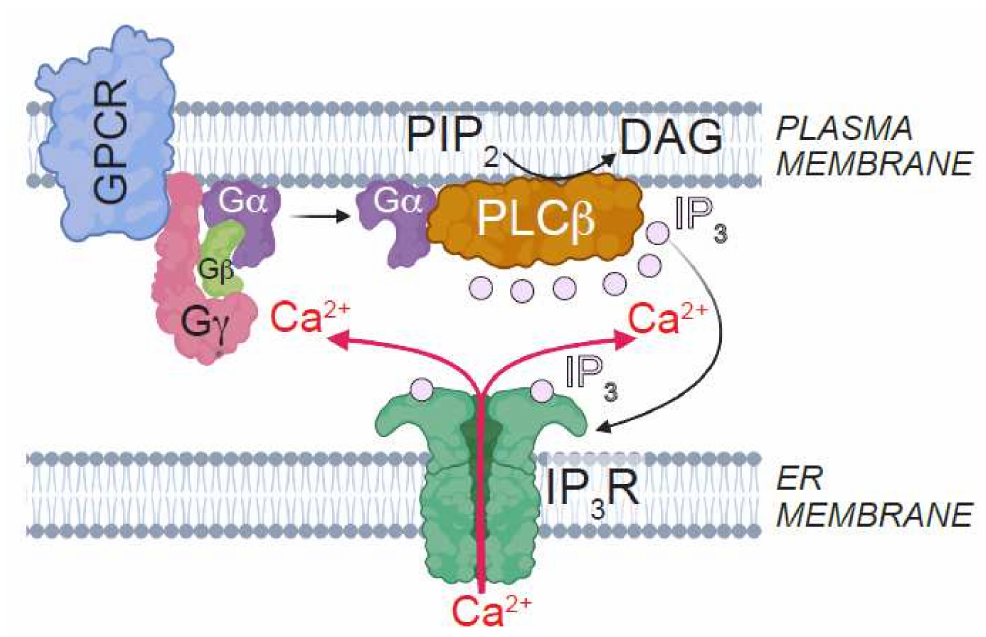
Figure 2. The PLC β –IP 3 R signaling axis. Stimulation of G α q-coupled GPCRs leads to the activation of PLC β . PLC β hydrolyzes the membrane phosphoinositide, PIP 2 , to generate the second messengers, diacylglycerol (DAG) and IP 3 . While DAG is retained in the plasma membrane, IP 3 diffuses through the cytosol and activates IP 3 Rs, which are localized to the ER membrane. Activation of IP 3 Rs results in the release of ER Ca 2+ . Image created with BioRender.com (accessed on 20 January